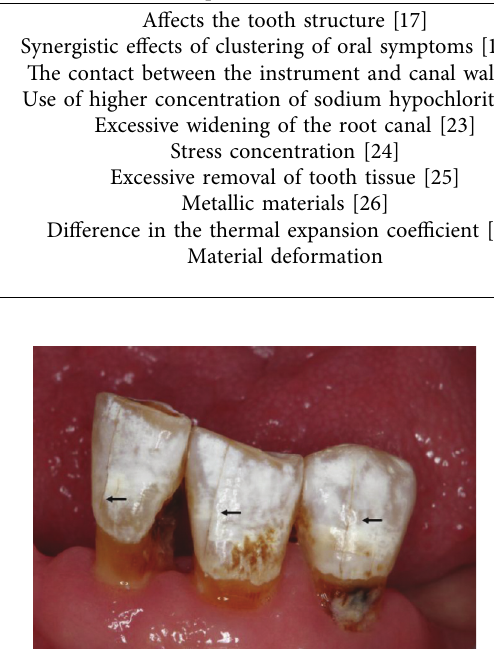
Figure 2: Clinical image of enamel crack lines (arrows) in patients affected by HNRT